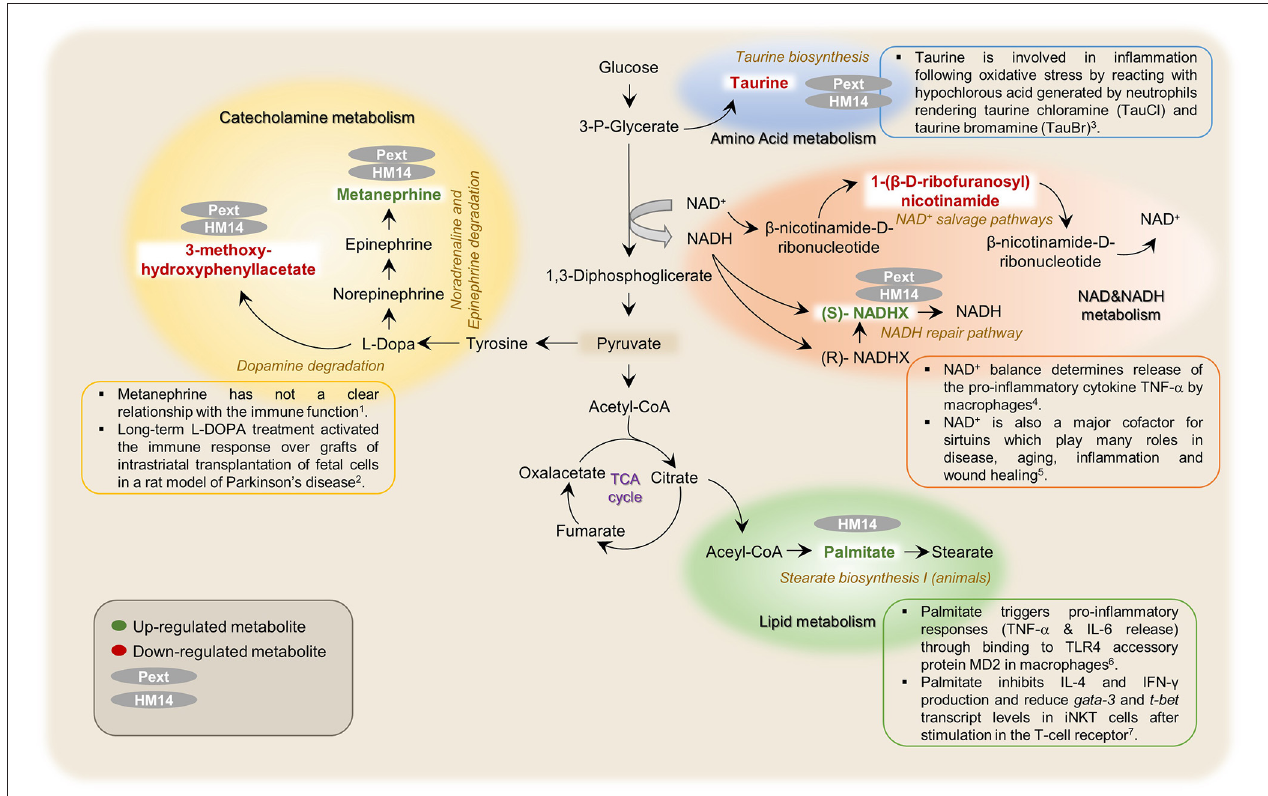
FIGURE 7 | Schematic representation of metabolic pathways that were found related with the possible immunomodulatory effects induced by the studied proteinaceous molecules (HM14 and Pext) over PBMCs. 1 ( Breger et al., 2017), 2 (Marcinkiewicz and Kontny, 2014), 3 ((Al-Shabany et al., 2016), 4 (Qiang et al., 2017), 5 (Wang et al., 2017), and 6 (Ko et al.,